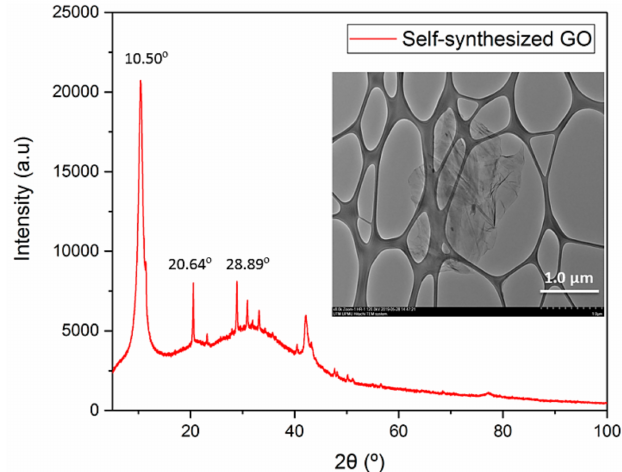
Figure 2. XRD spectrum of self-synthesized GO nanosheet (Inset: TEM image of GO nanosheet).